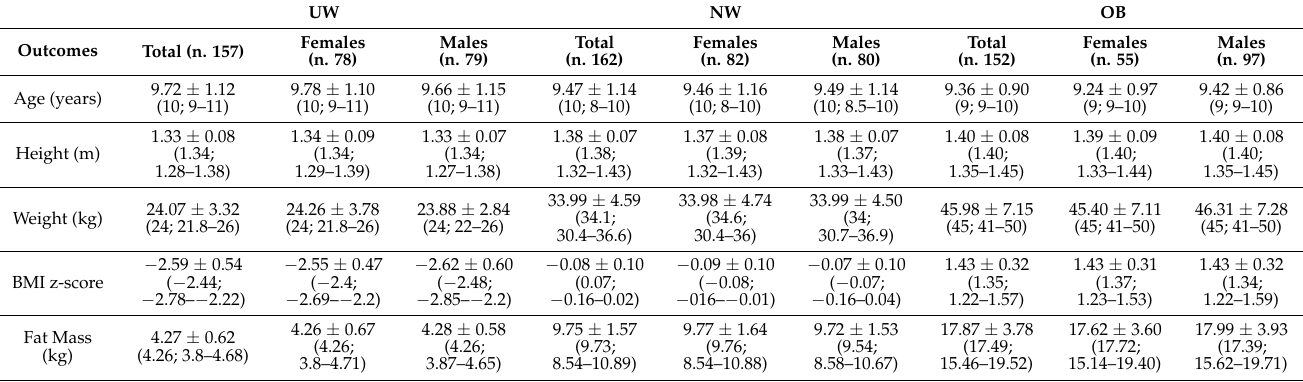
Table 1. Anthropometrics’ characteristics of the whole